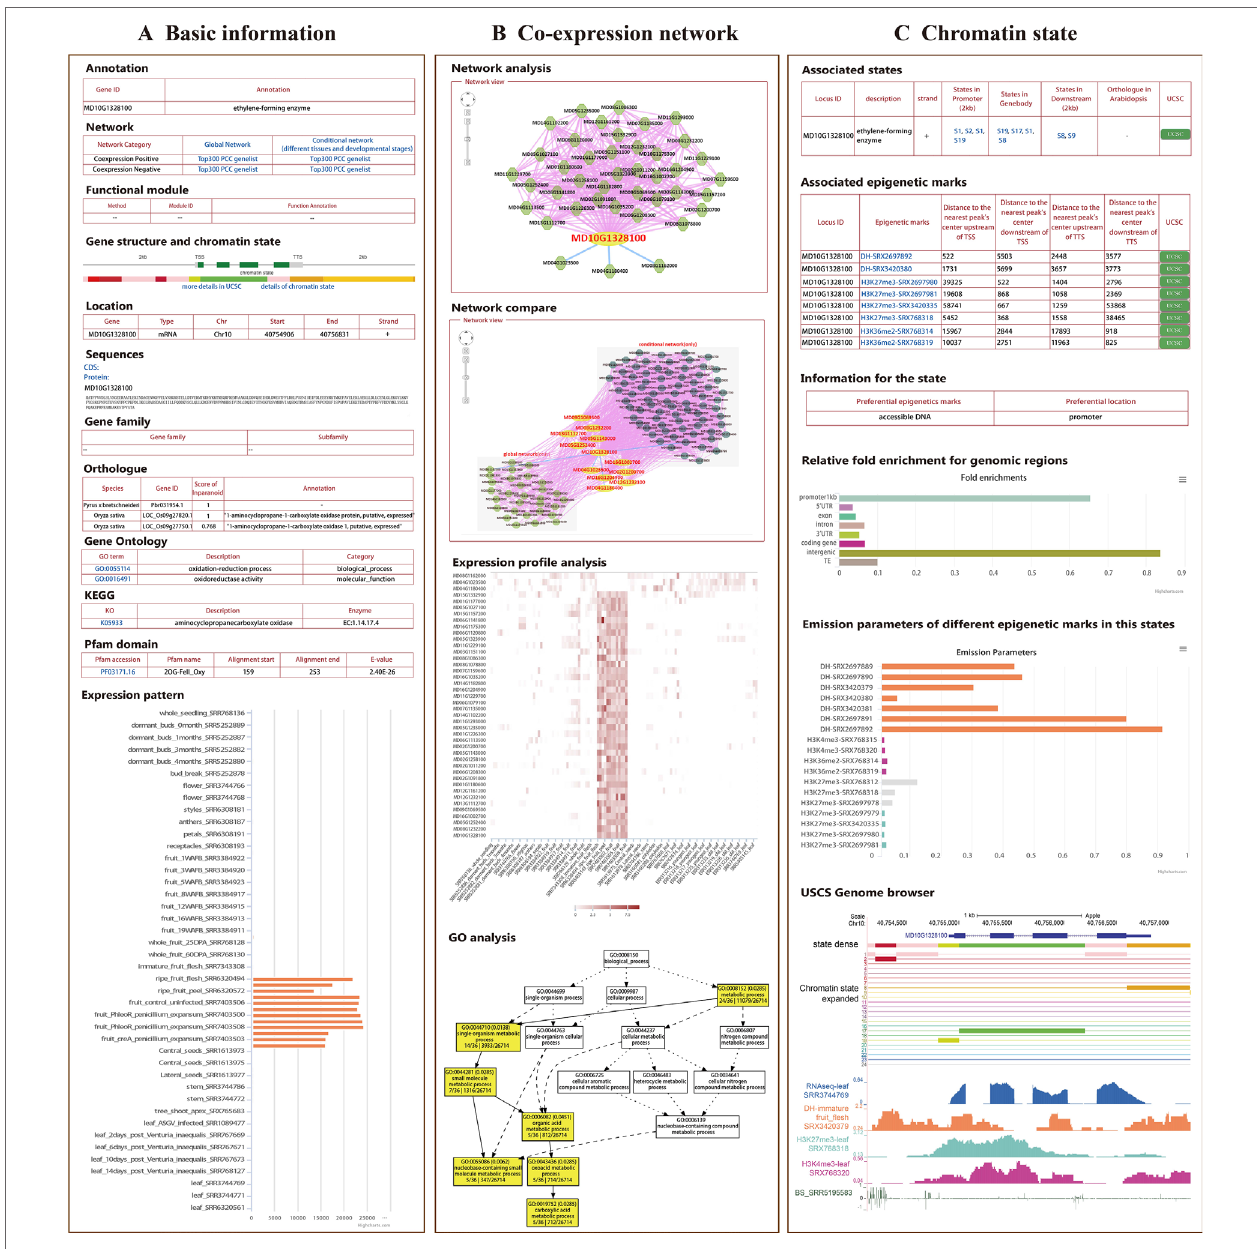
FIGURE 1 | General description of AppleMDO functions. (A) Basic information for MdACO1 obtained by using the search function in AppleMDO, including annotation, co-expression network, gene structure, chromatin states (with warm colors representing activation of transcription and cool colors representing inhibition of transcription), gene location, CDSs and proteins, gene family, orthologous genes in 13 species, gene ontology, Kyoto Encyclopedia of Genes and Genomes, Pfam domain, and expression patterns in various tissues and under different stresses. (B) Co-expression network analysis of MdACO1 . A global or tissue-preferential co-expression network of MdACO1 was found by searching for MdACO1 (MD10G1328100) in an AppleMDO network analysis, including positive co-expression relationships, negative co-expression relationships, and possible protein–protein interactions. Further network comparison analysis has been implemented between the global network and tissue-preferential network. Moreover, for all genes in the network, we provide a GO enrichment analysis tool to further annotate gene functions and expression profile analysis tools to visualize gene expression levels. (C) Chromatin state analysis of MdACO1 . Associated states and epigenetic marks of genes were found by searching for a single gene or a list of genes in gene analysis. Relative fold enrichment for genomic regions and emission parameters of different epigenetic marks in the state were found by searching for the state in state analysis. Furthermore, detailed information on states and the signals of epigenetic markers can be visualized in the genome using the UCSC genome